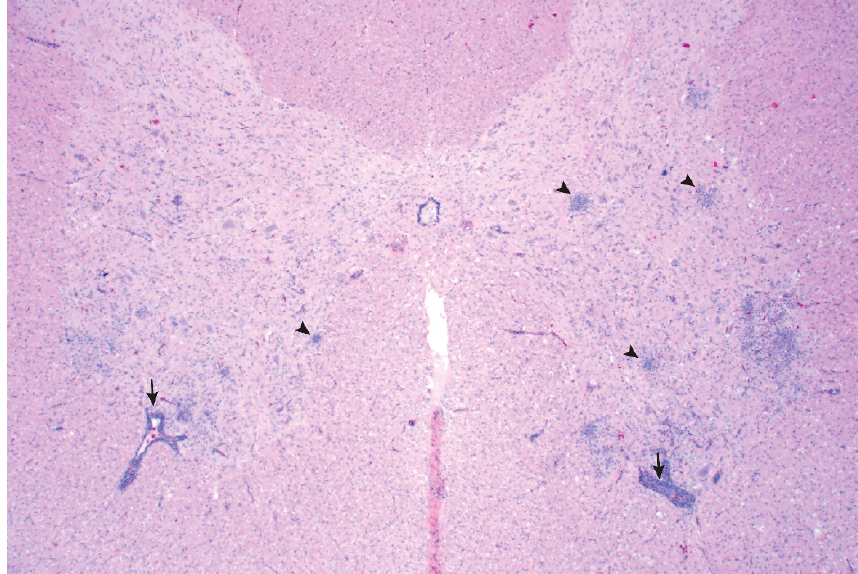
Figure 2. Pig 25 spinal cord: Poliomyelitis characterized by multifocal areas of gliosis (arrowhead) and perivascular inflammatory infiltrates (arrow). The magnification used was 2×.